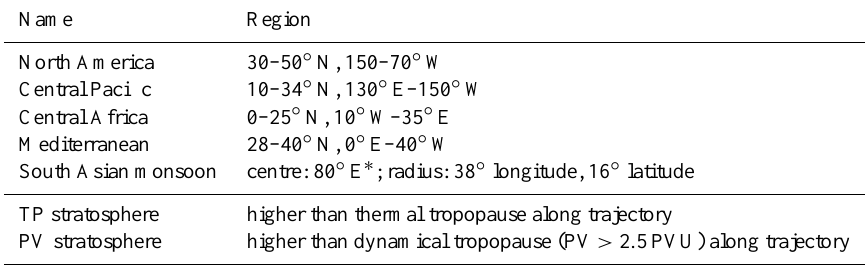
Figure 11. Distribution of source regions for all the CARIBIC flights. The colour code shows the percentage of trajectory points that were below 5km altitude in the preceding 10 days per 4 ◦ × 4 ◦ grid box. Upper left panel: source regions for trajectories starting north of the wind reversal. Lower left panel: source regions for trajectories starting south of the wind reversal. Right panels show the corresponding standard deviation of the percentages in the monsoon months June to September per grid box for all grid boxes reached by trajectories from at least 2 months (see also Figs. S26–S29). Table 2. Receptor regions used in the analysis of the FLEXPART forward